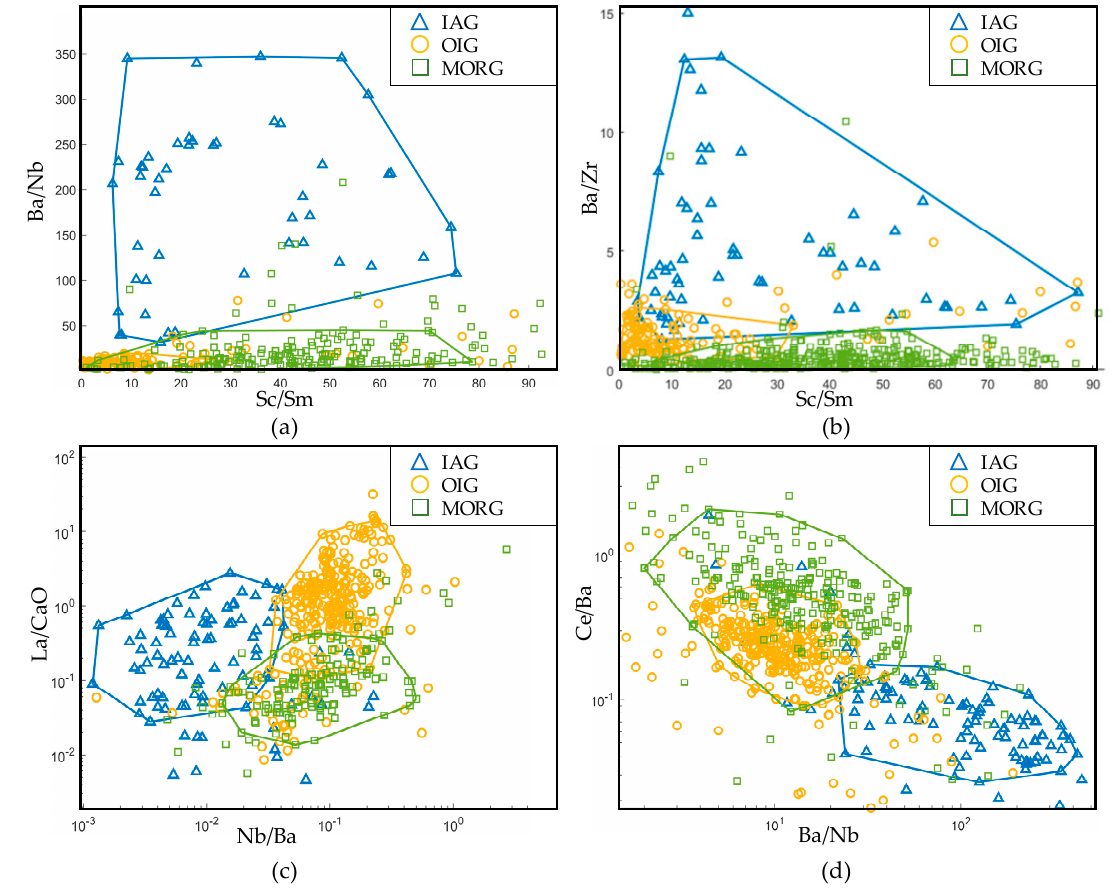
Figure 11. Discrimination diagrams for IAG and non-IAG. All four diagrams have a 0.85 confidence region. ( a , b ) are in linear coordinates; ( c , d ) are in logarithmic coordinates.